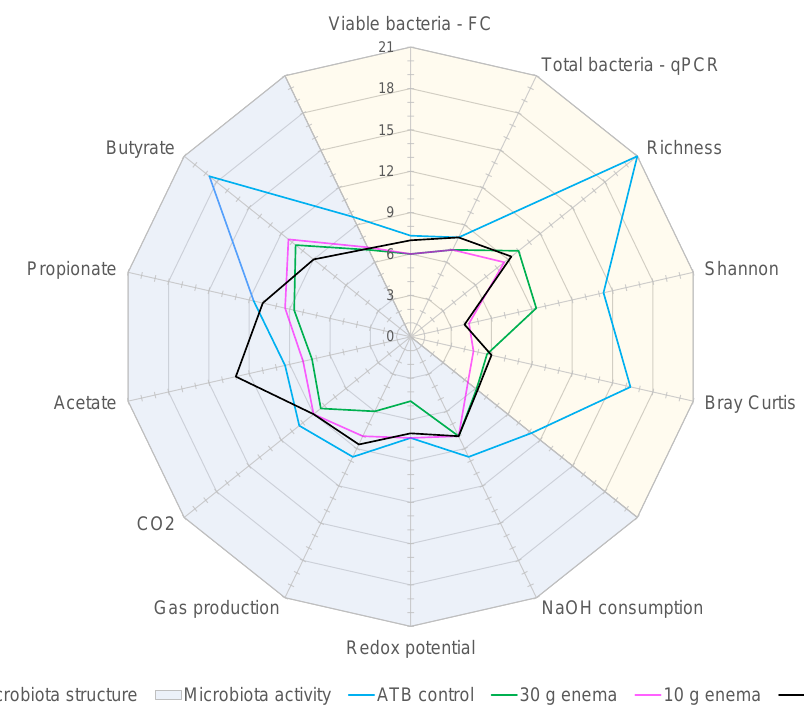
Figure 6. Effect of fecal microbiota transplantation (FMT) treatment on the duration of dysbiosis.